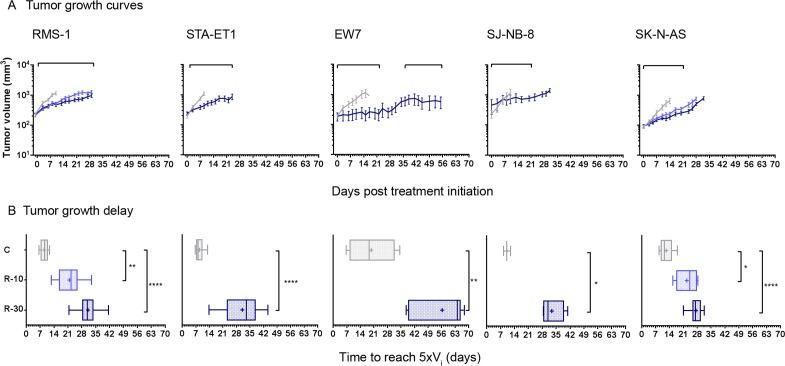
Antitumor activity of regorafenib in vivo against various subcutaneous pediatric tumor xenografts.Animals bearing subcutaneous RMS-1 rhabdomyosarcoma, STA-ET-1 and EW7 Ewing sarcoma, SJ-N-B8 and SK-N-AS neuroblastoma xenografts were treated orally with regorafenib at 10 mg/kg/d (light blue; R-10) and/or 30 mg/kg/d (dark blue, R-30), or with vehicle (grey, C) for a minimum of 21 days; treatment periods are indicated by bars above the graphs. (A) Graphs show arithmetic means ± standard error of mean (SEM) of tumor volumes. (B) Times to reach 5 times the initial volume (Vi) of 3–14 tumors per group is displayed as box plot, + represents means and error bars minimum to maximum values. Statistical significance was estimated by Mann-Whitney or Kruskal-Wallis tests, ****p<0.0001 ***<0.001, **<0.01., *<0.05.